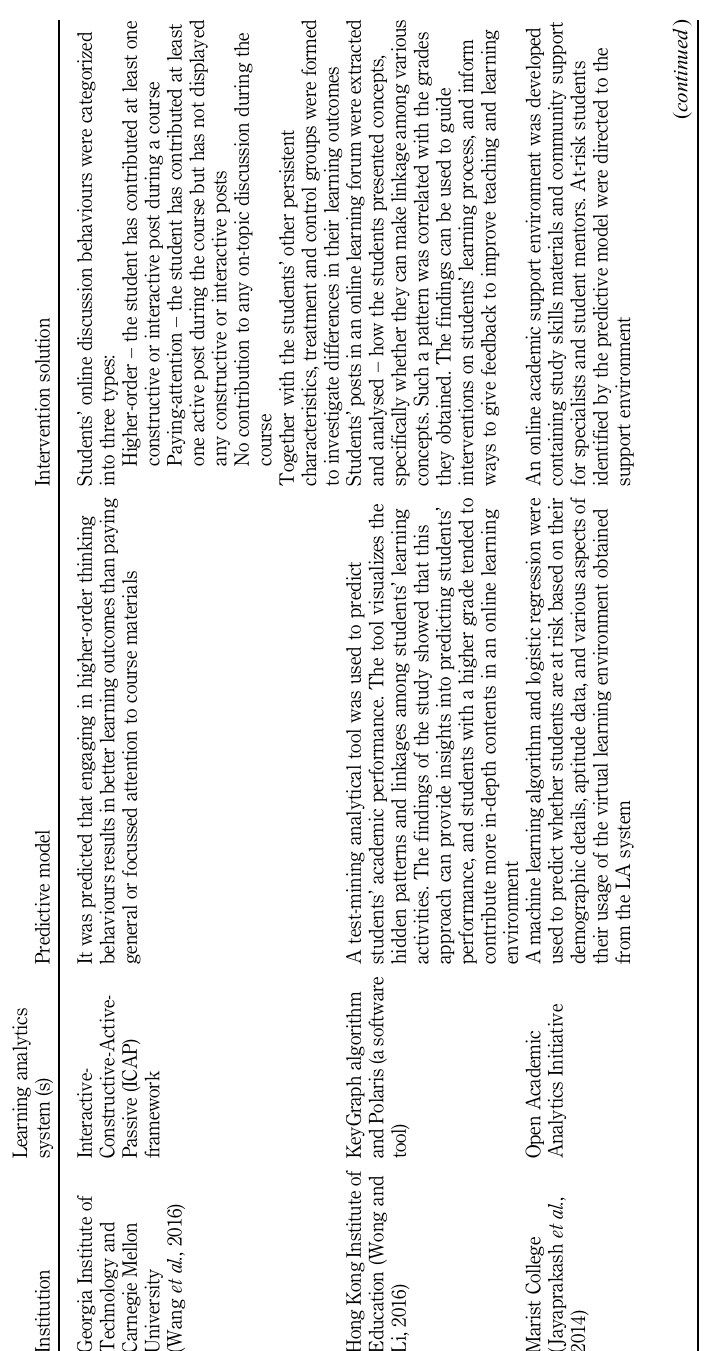
Table VII. Summary of predictive model and intervention solution for selected case